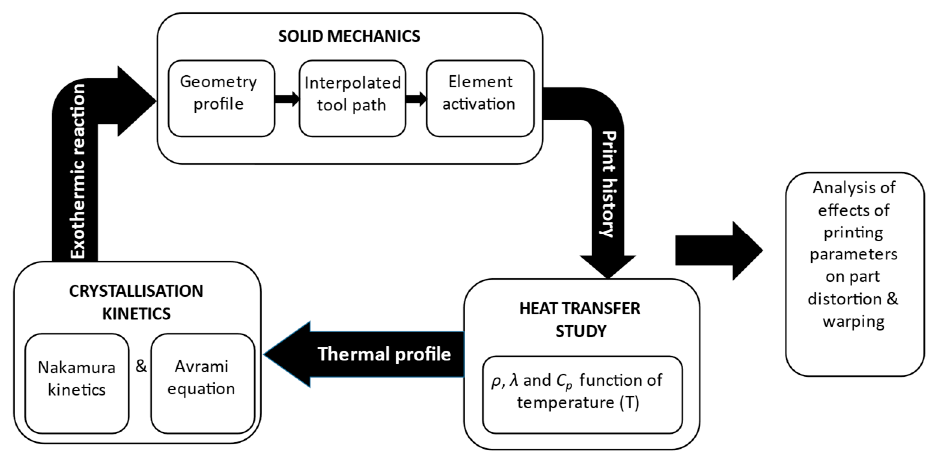
Figure 1. Process plan.